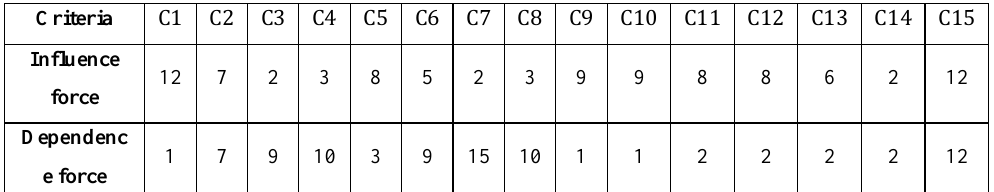
Table 12. Separation of influence and dependence forces